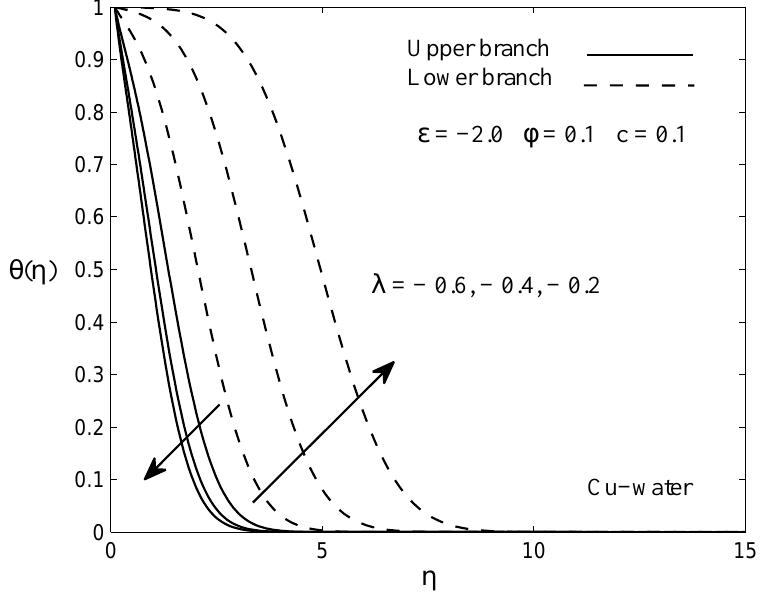
Figure 13. Effect of mixed convection parameter λ on the variation of temperature